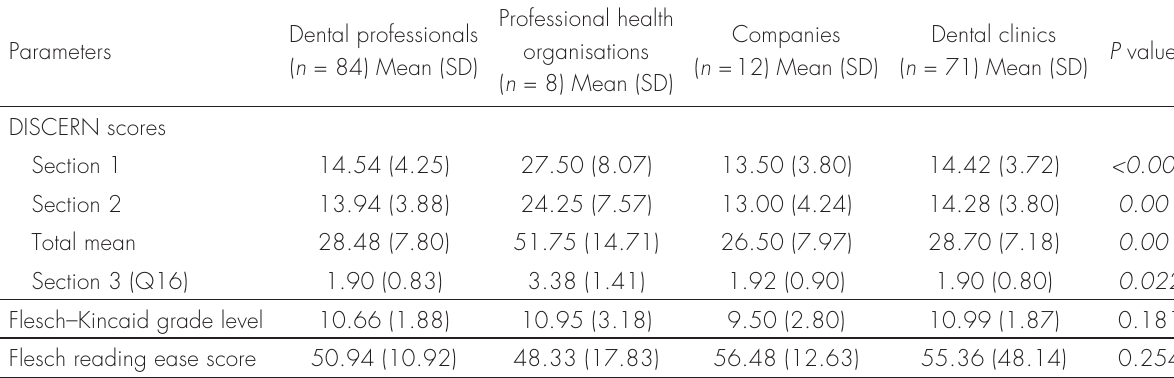
Table I. Comparison of DISCERN, FRE, FKGL scores among the groups.